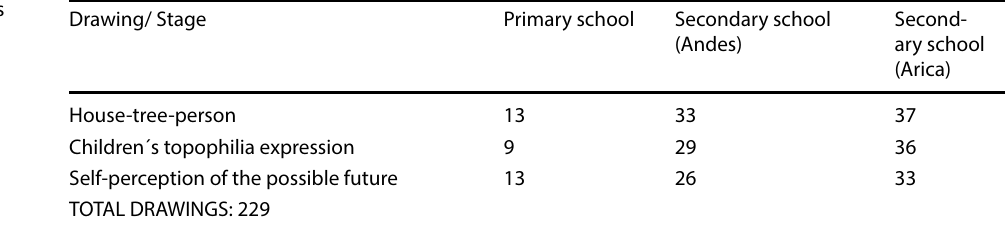
Table 2 Aymara children´s drawings distribution